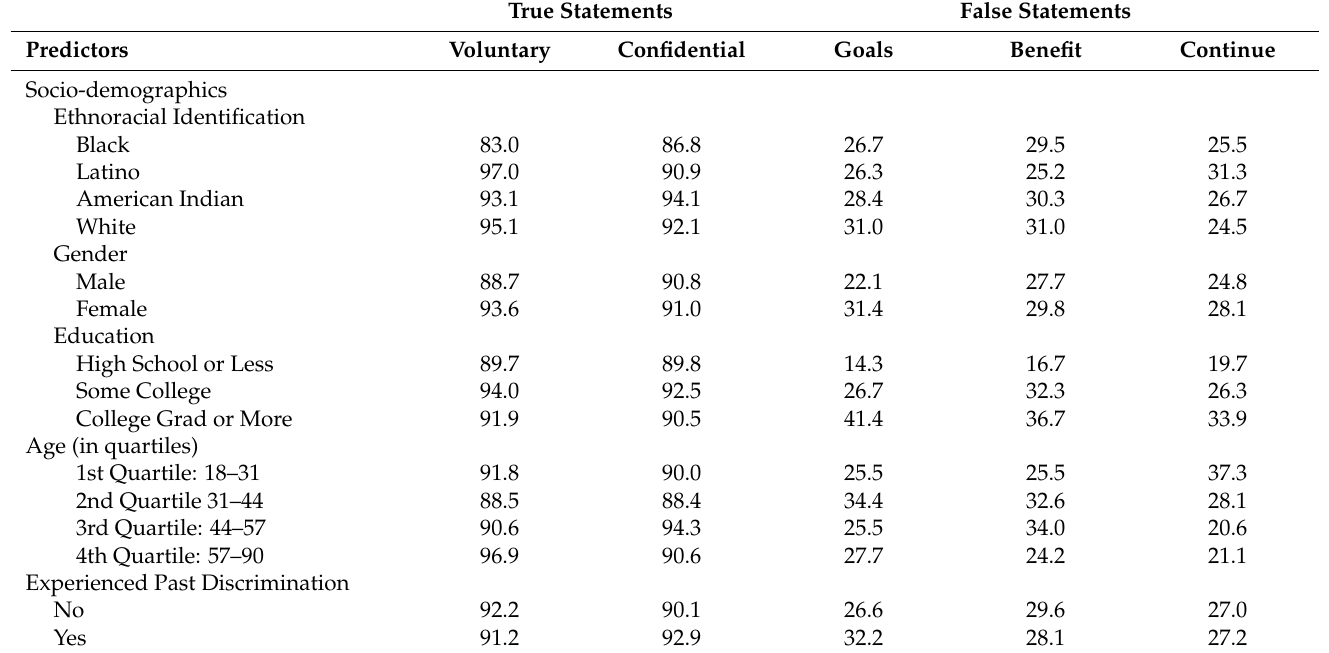
Table 4. Percentage of Respondents Providing a Correct Answer to MRL Questions by Socio- demographic Characteristics and Experienced Past